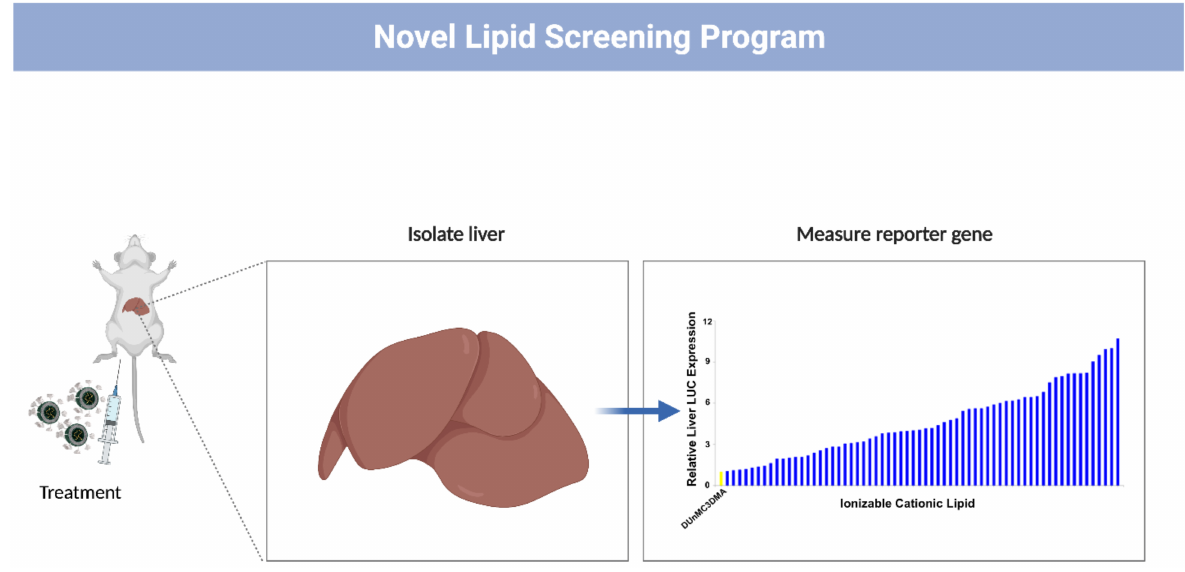
Figure 1. Novel lipid screening model. In vivo activity of novel ionizable lipids using a reporter gene firefly luciferase encoded in a mRNA are evaluated by intravenous administration in murine